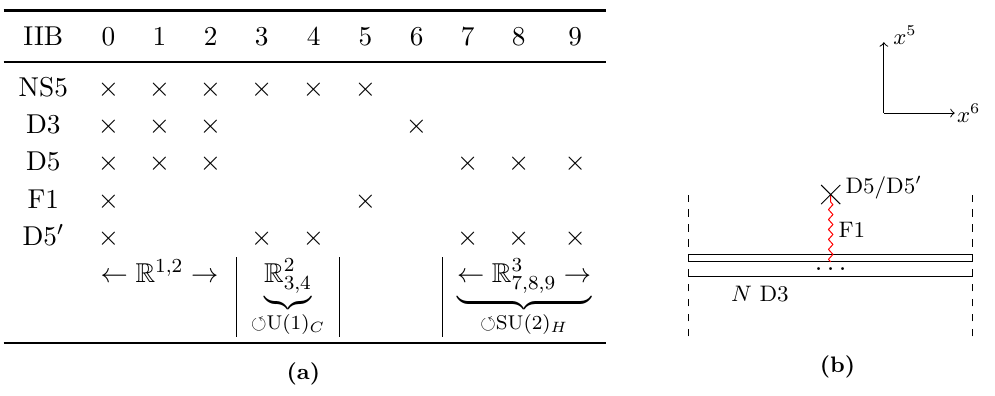
Figure 4. Brane realisation of Wilson line defects.